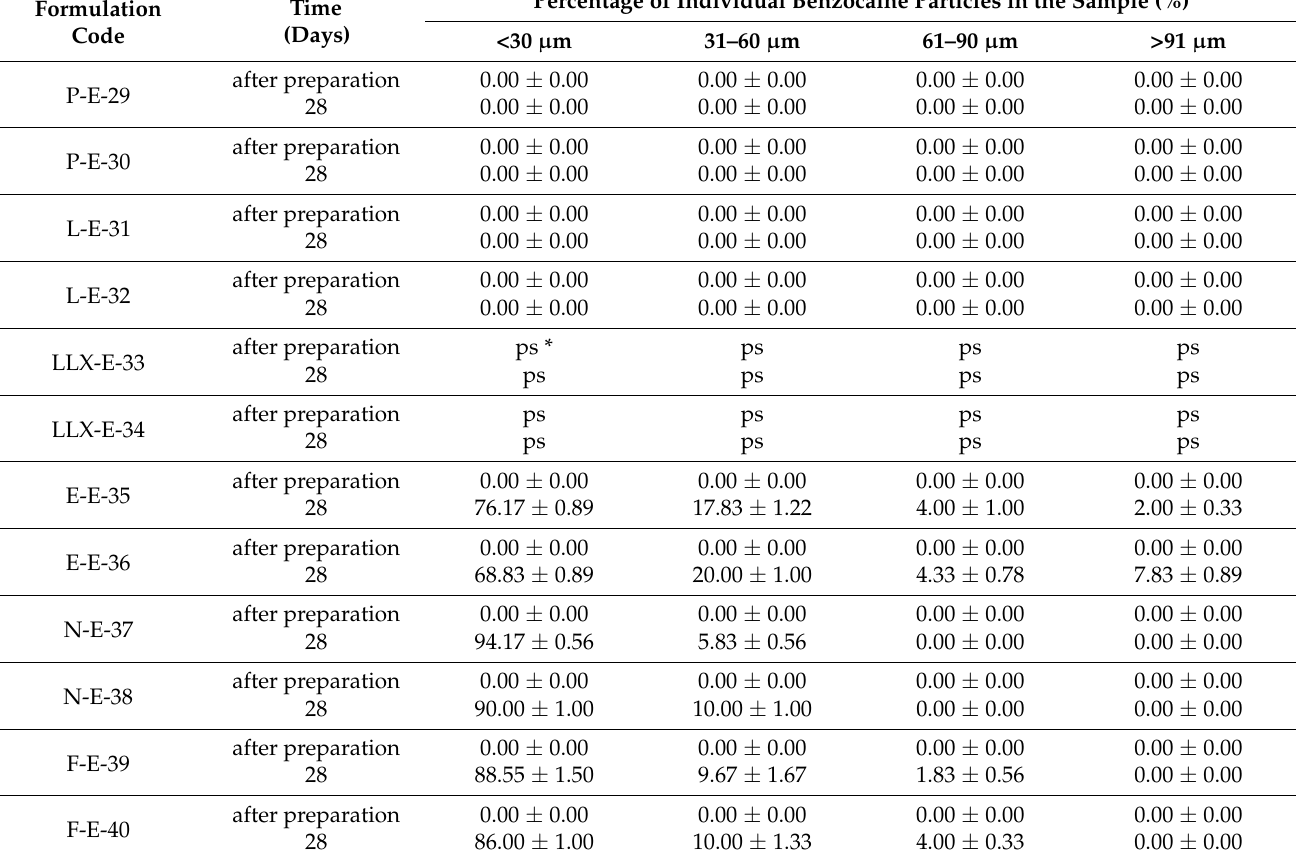
Table 4. Change in benzocaine particle size in emulsion ointments depending on the used base and storage